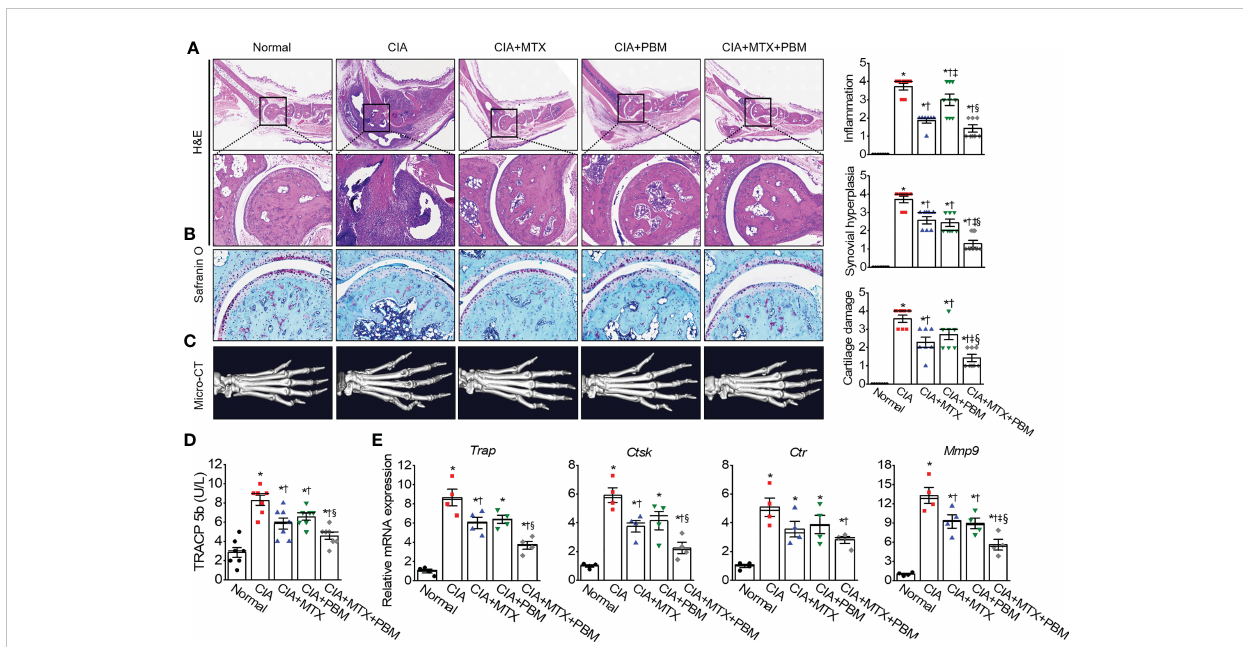
FIGURE 3 PBM mitigates histopathological abnormalities in CIA mice. (A) Histological analysis of 3 m m sections of paraf fi n-embedded ankle joints tissue stained with hematoxylin and eosin (H&E). Photographs are of representatives from each experimental group. Degree of synovial in fl ammation and hyperplasia was evaluated on a scale from 0 to 4. Representative images of ankle joints tissue stained with (B) Safranin-O in each experimental group. Degree of cartilage damage was evaluated on a scale from 0 to 4 ( n = 7). (C) Representative photographs of 3D reconstruction of micro- computed tomography of the hind paws of mice with CIA. (D) The serum level of bone marker TRACP 5b in each group ( n = 7). (E) The relative mRNA of osteoclastogenesis-related markers in paws were detected by real-time PCR ( n = 4). Data are shown as mean ± SE. * p < 0.05, compared to Normal. † p < 0.05, compared to CIA. ‡ p < 0.05, compared to CIA+MTX. § p < 0.05, compared to